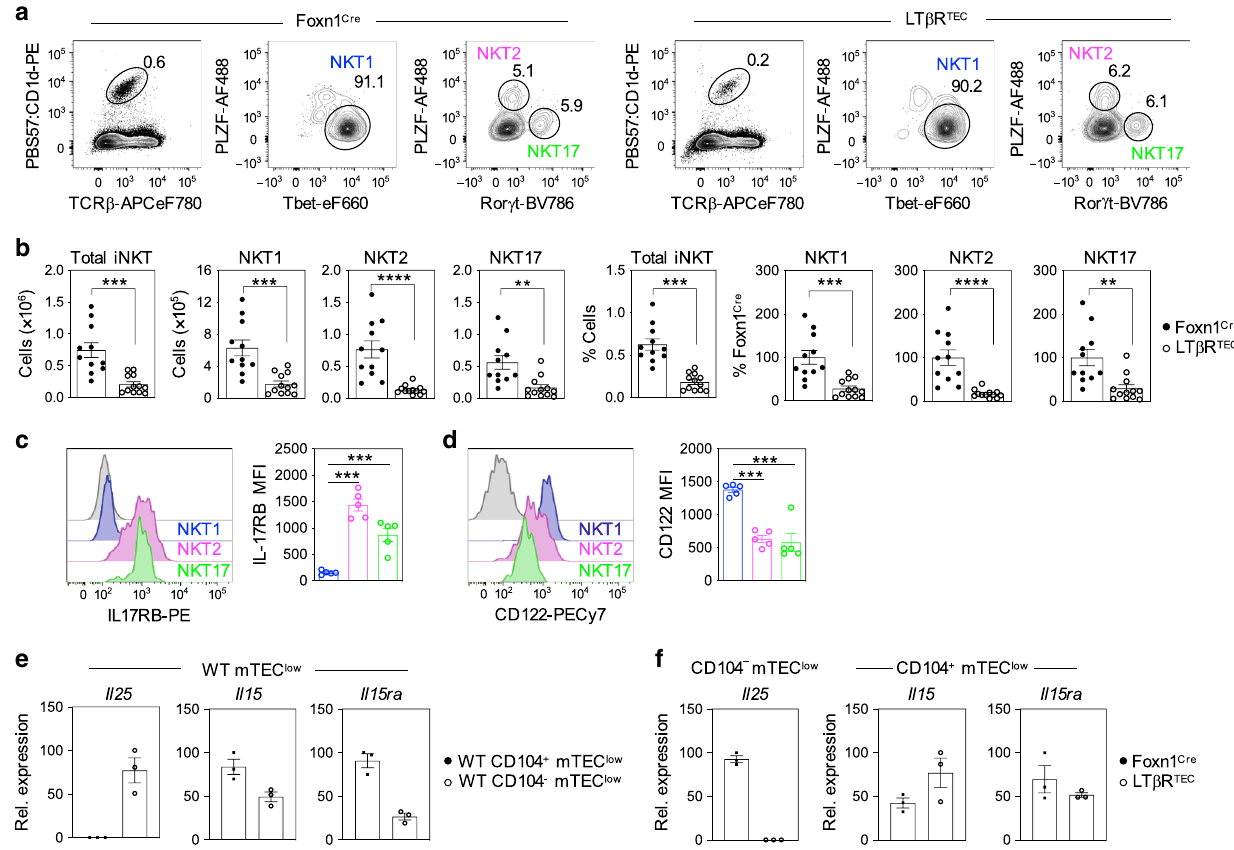
Fig. 4 LT β R expression by thymic epithelium controls the intrathymic iNKT cell pool. a Thymocytes from Foxn1 Cre and LT β R TEC mice, analysed for expression of TCR β and reactivity with the PBS57-loaded CD1d tetramer to identify iNKT cells. TCR β + PBS57:CD1d + cells were analysed for intracellular expression of PLZF, Tbet and ROR γ t to identify NKT1, NKT2 and NKT17 subsets as indicated. b Absolute numbers of iNKT cells and iNKT subsets in Foxn1 Cre controls ( n = 11 biologically independent samples, closed symbols) and LT β R TEC mice ( n = 12 biologically independent samples, open symbols), over three independent experiments. Percentages relative to Foxn1 Cre controls are also shown. Signi fi cant P values using two-tailed unpaired t test as follows: no. of total iNKT P = 0.0002, no. of NKT1 P = 0.0003, no. of NKT2 P ≤ 0.0001, no. of NKT17 P = 0.0021, % Total iNKT P = 0.0001, % NKT1 P